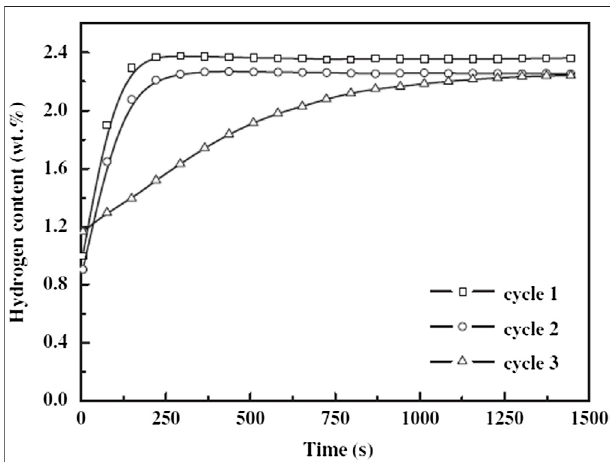
FIGURE 8 | Reversibility study for the initial three cycles of the destabilized MgH 2 – LiAlH 4 composite under a hydrogen pressure of 3 MPa and at 300 ° C (Ding et al.,